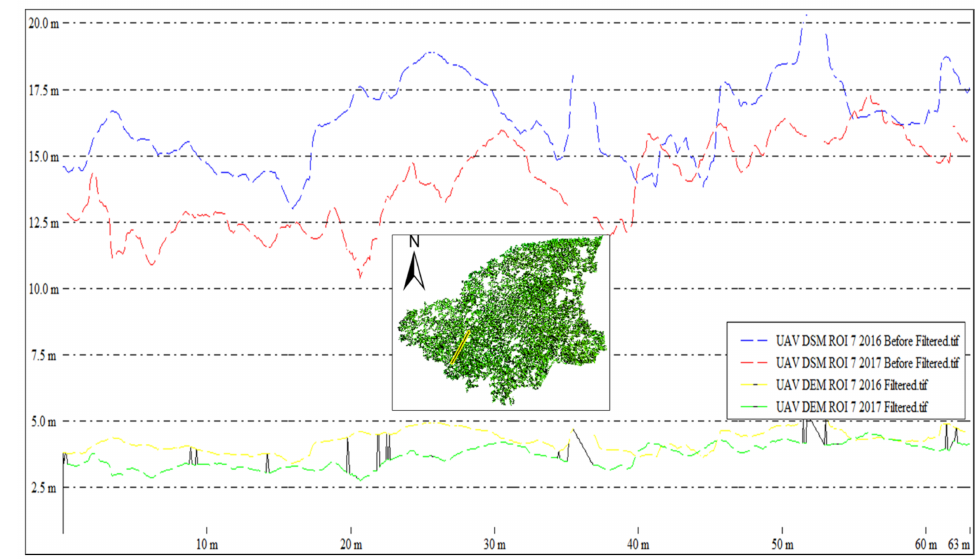
Figure A13. Average height comparison between filtered and unfiltered for ROI 7.